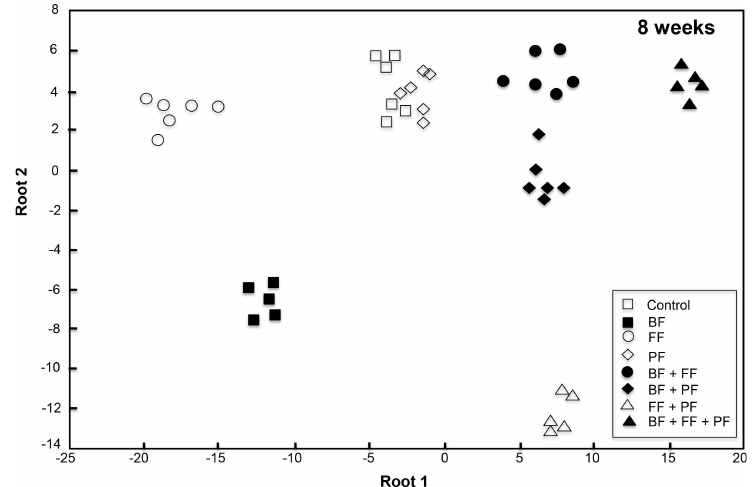
Figure 3. Discriminant function analysis of the soil phospholipid fatty acid pattern at 8 weeks after nematode inoculation. The model used trophic groups of nematodes as groups ( n = 8) and PLFAs ( n = 13) as dependent variables. Control—none, bacterial feeders—BF ( Acrobeloides buetschlii ), fungal feeders—FF ( Aphelenchoides saprophilus ), plant feeders—PF ( Pratylenchus penetrans ).